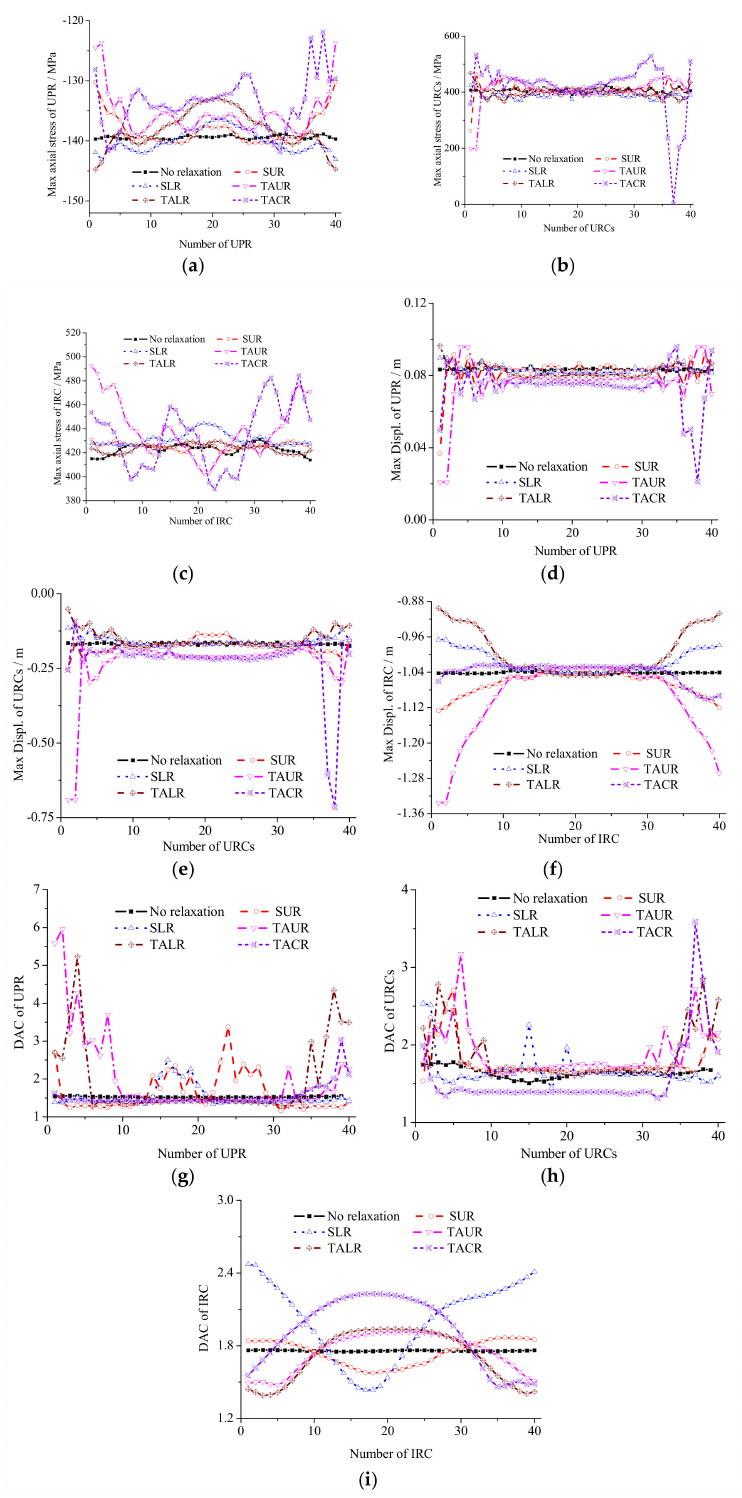
Figure 9. Structural response distributions under di ff erent cable relaxation. ( a )Axial stress of UPR; ( b ) Axial stress of Upper-Pressure Ring (URCs); ( c ) Axial stress of Inner Ring Cables (IRC); ( d ) Displ. of Z direction of UPR; ( e ) Displ. of Z direction of URCs direction of URCs; ( f ) displacement amplification coe ffi cient (DAC) of IRC; ( g ) displacement amplification coe ffi cient (DAC) of UPR; ( h ) DAC of URCs; ( i ) DAC of